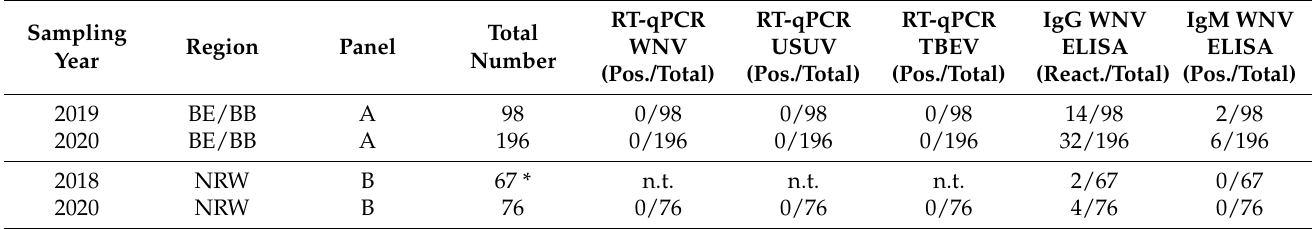
Table 2. Results of virological and ELISA testing of horse sera from panel A region Berlin/Brandenburg (BE/BB) and panel B North Rhine–Westphalia